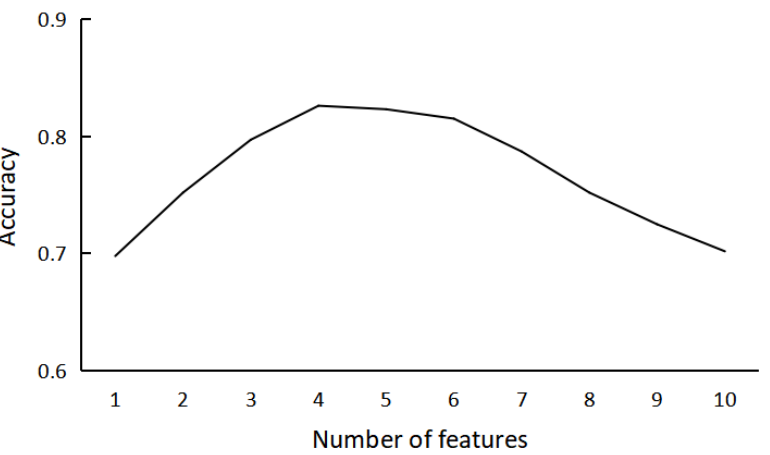
Figure 6. The relationship between the accuracy of W recognizer and its number of features. (The accuracy is the highest after comprehensive consideration of Youden’s index).